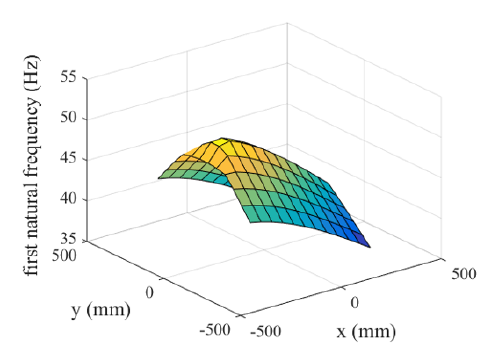
Figure 12. Variation of the first natural